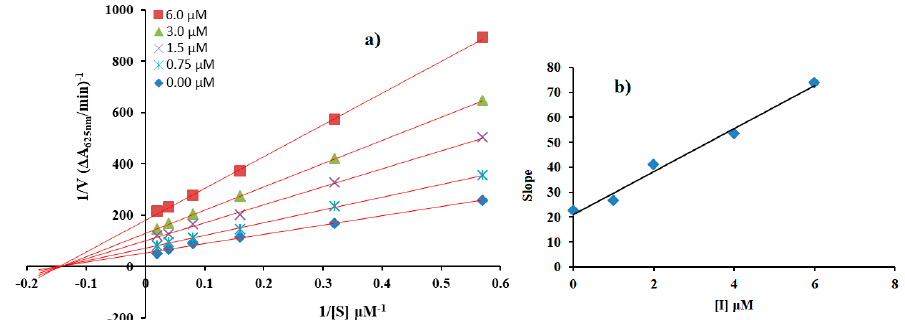
Figure 4. Kinetic analysis results for target molecule 4b . ( a ) Lineweaver-Burk plots for the inhibition of urease in the presence of compound 4b ; concentrations of 4b were used as 0, 1, 2, 4, and 6 µM, respectively. Substrate (urea) concentrations, 1.57, 3.12, 6.25, 12.5, 25, and 50 µM, were used, respectively; ( b ) The secondary replot of the Lineweaver-Burk plot, slope vs. various concentrations of 4b